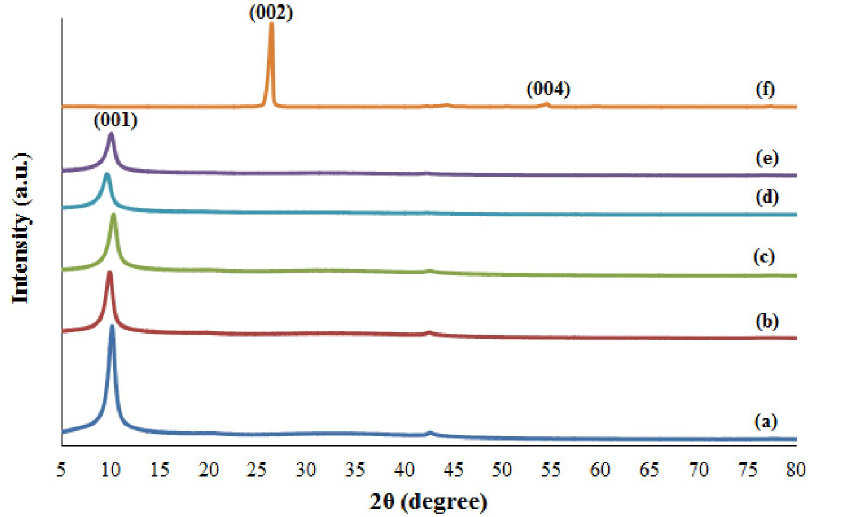
Fig 2. XRD patterns of (a) GO20, (b) GO40, (c) GO60, (d) GO72, (e) GO80, and (f) graphite.